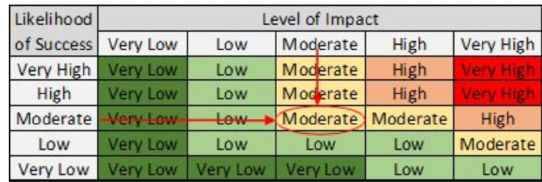
Figure 6. Initial Risk Determination. Phase 5: Implement Controls. In Figure 5, the table with a green-colored header shows this phase. This phase analyzes details of the process where the chosen control